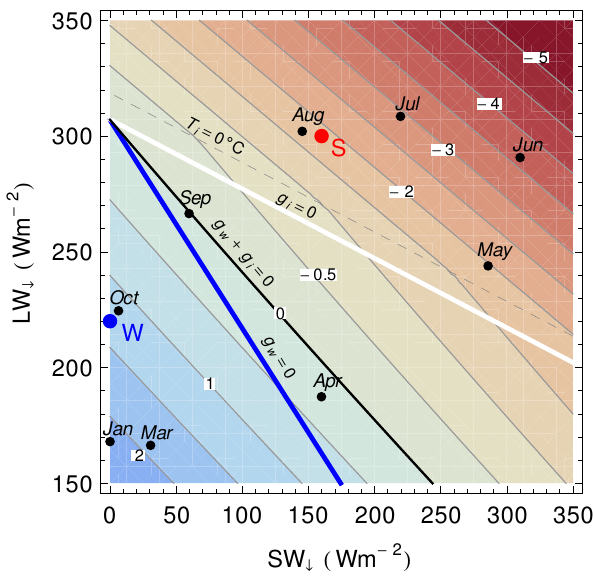
Fig. 9. Contour plot of ice growth rates in cmday − 1 for mean ice thickness h m = 1m and ice concentration C = 0 . 7. On the x- axis is the downwelling shortwave radiation, on the y-axis the downwelling longwave radiation. The black dots correspond to the typical monthly-mean forcing in the Arctic according to Maykut and Untersteiner (1971). The blue and white lines mark the zero- crossing of the growth rates for open water and over ice, which are independent of the state of the ice. The thick black line is the zero-crossing of net growth rate, and depends on the state of the ice. At the dashed grey line, the ice surface temperature is at the melting point of 0 ◦ C. The larger blue and red dots, labelled “W” and “S”, mark typical winter and summer conditions, for which the conditional probability distributions of growth rate in Fig. 10 are calculated.